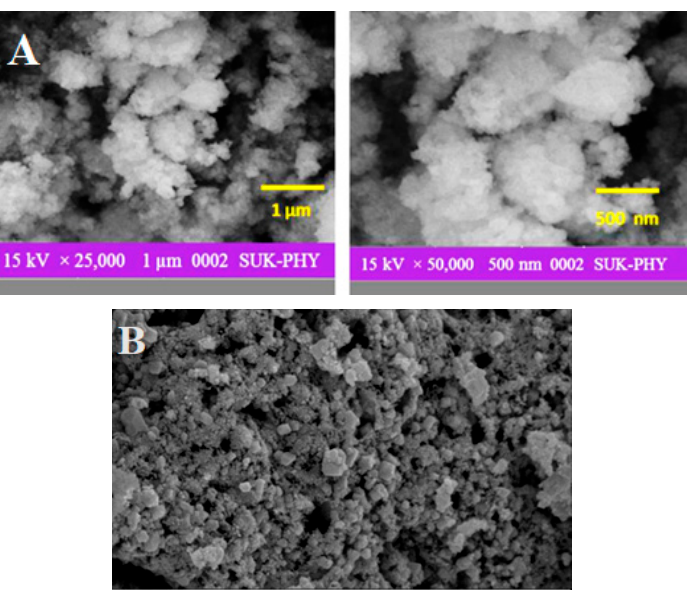
Figure 3. ( A ) FE-SEM micrographs of NiO NSs [36]; ( B ) SEM micrograph of NiCo 2 O 4 /CeO 2 sample [37].